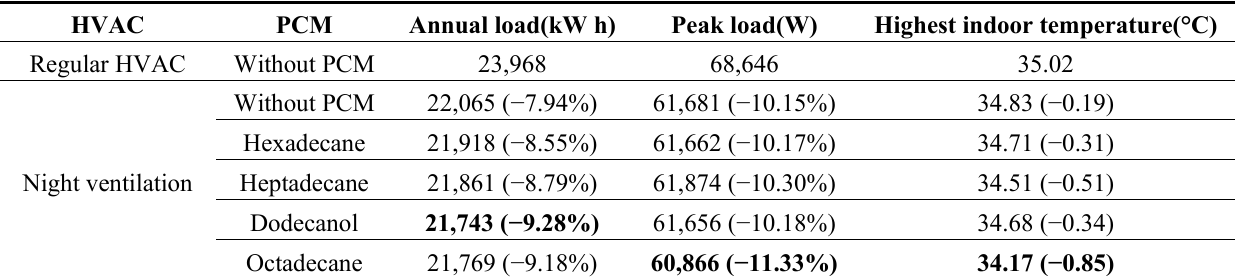
Table 6. Indoor thermal characteristics of the cooling period with night